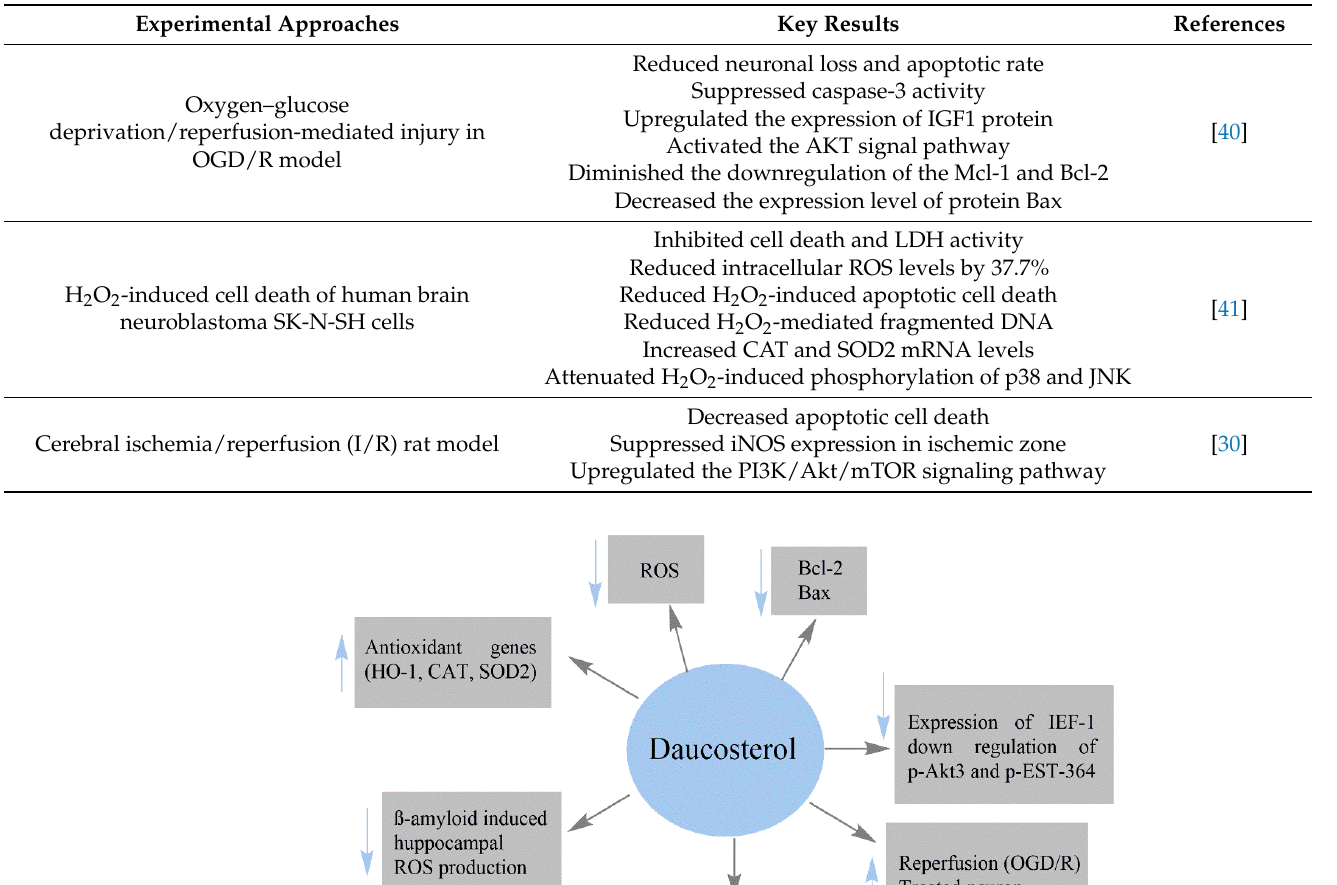
Table 5. Neuroprotective effects of Daucosterol.